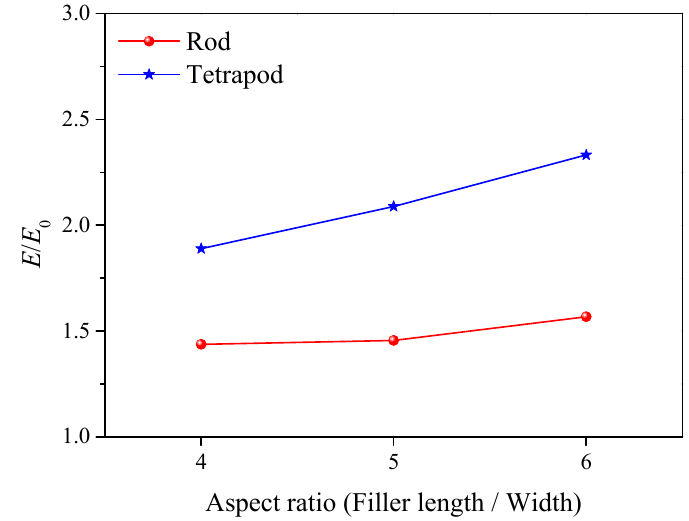
Figure 3. Plot of relative elastic modulus versus aspect ratio for tetrapod and nanorod nanocomposites. Blue lines represent results from the tetrapod filled composites, while red lines represent results from the rod filled composites